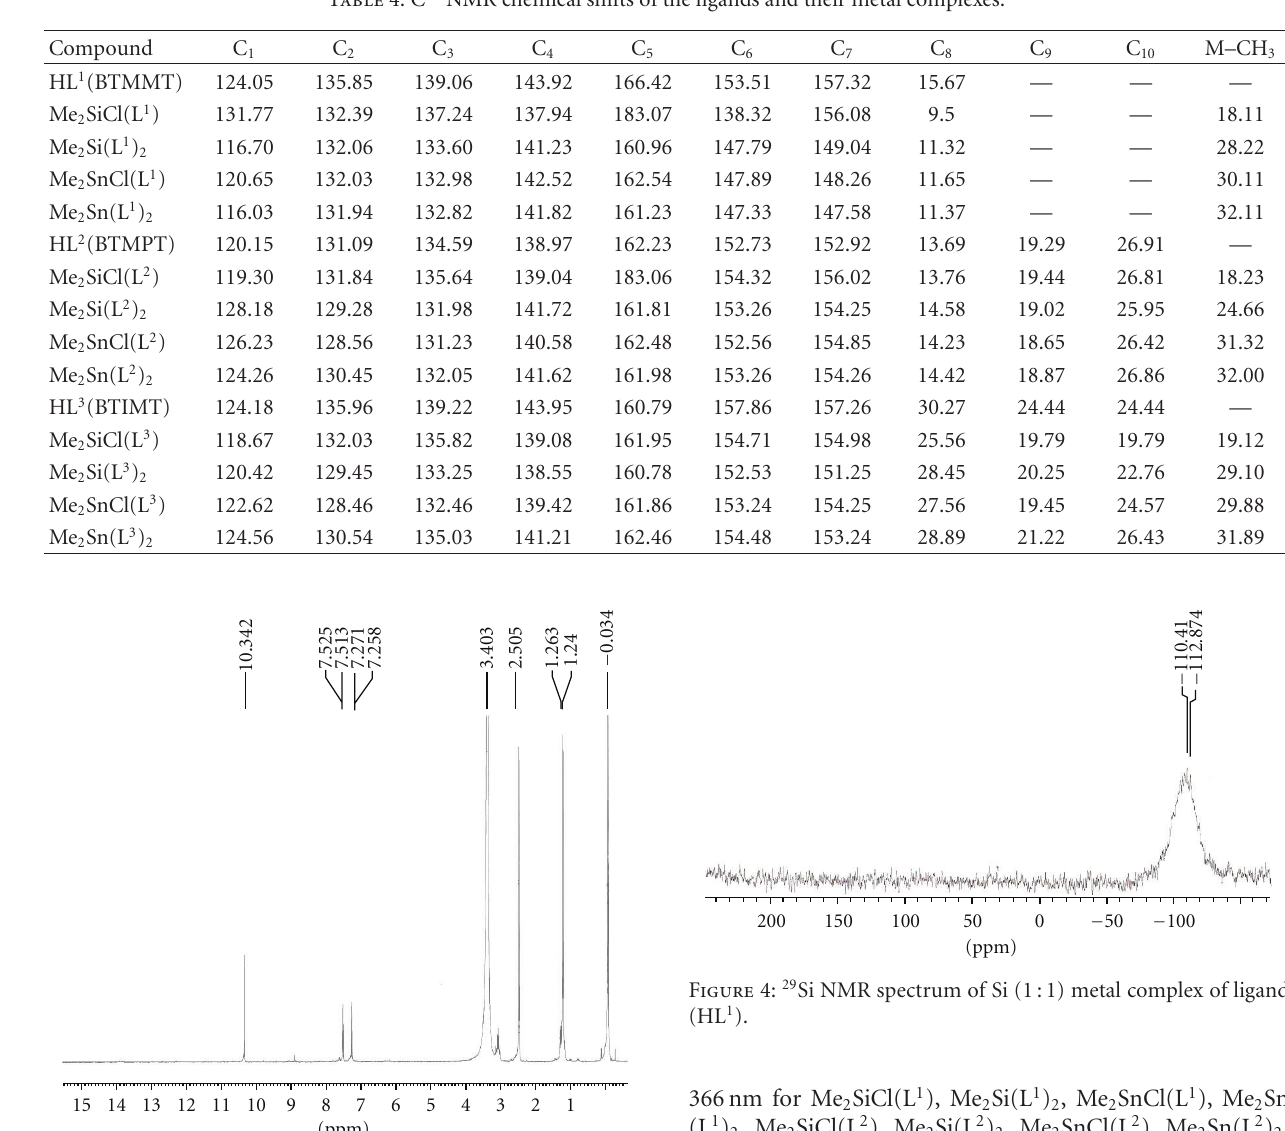
Table 4: C 13 NMR chemical shifts of the ligands and their metal complexes.